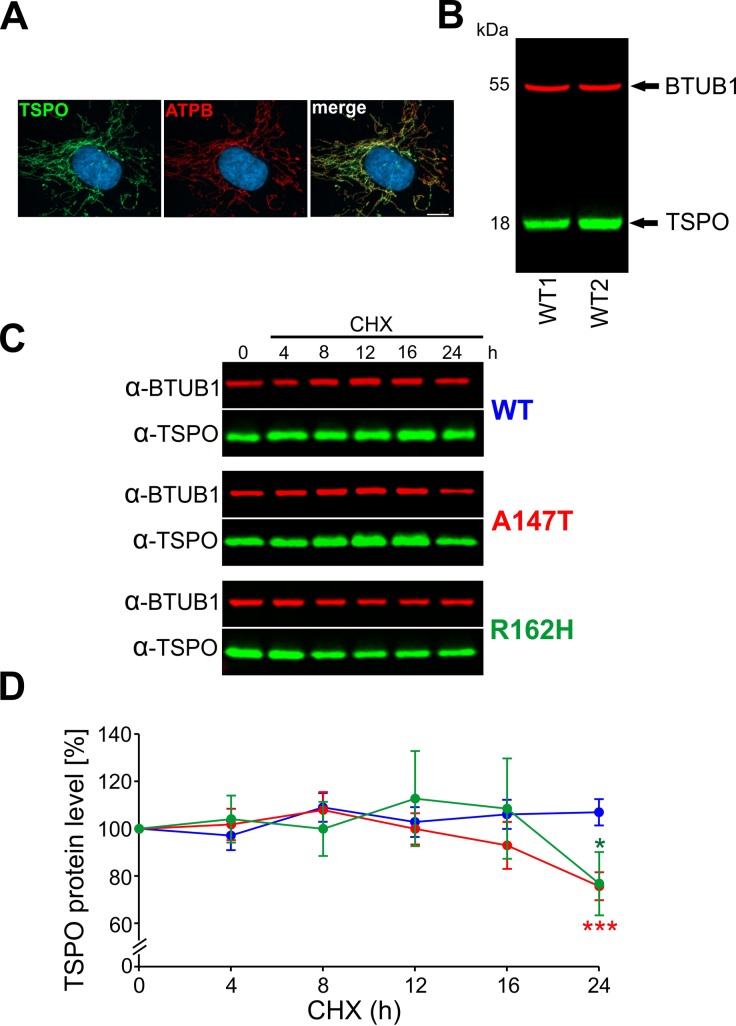
Analysis of protein stability by the cycloheximide protein degradation assay of wt and mutant TSPO proteins.(A) TSPO is localized to mitochondria in primary dermal fibroblasts. (B) Lysates of human primary fibroblast cells were subjected to Western blotting to detect endogenous TSPO. (C) Fibroblasts from carriers of wt and homozygous A147T and R162H mutations of TSPO were treated with cycloheximide (25 μg/ml) for the indicated times, and endogenous TSPO was then detected by specific rabbit anti-TSPO antibody. Equal amounts of protein were subjected to Western blot analyses, as determined by comparing the amount of beta 1 tubulin. (D) Densitometry results for endogenous TSPO after treatment with cycloheximide were quantified as percentage of the initial TSPO protein level (0h of CHX treatment) and normalized to the intensity of beta 1 tubulin, and then plotted. Data are shown as mean ± SEM from three independent experiments.